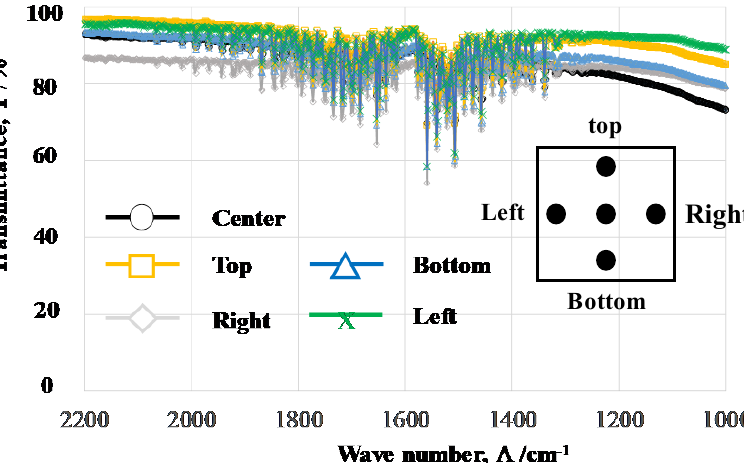
Figure 11. Measurement of the transmittance diagrams for LL-specimen at different five positions on the acicular microtextured surface of LL-specimen.